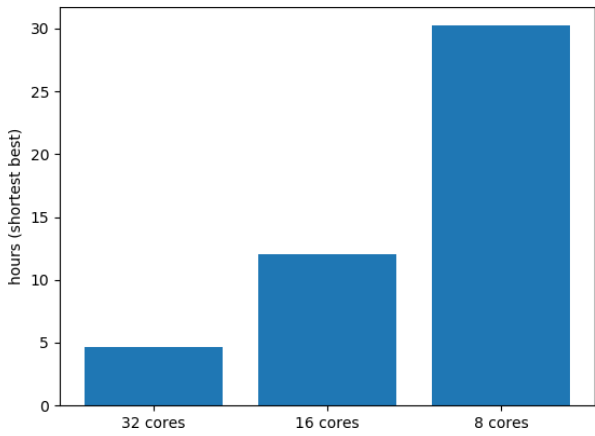
Figure 2. Processing time in hours to complete one year of simula- tion at 0.2 ◦ resolution in a “global” (65 ◦ S–65 ◦ N, 180 ◦ W–180 ◦ E) configuration spanning water depths of 10–100m. The high lati- tudes were removed because the model assumes constant salinity and the model does not include a representation of sea ice. Simula- tions were undertaken on an AMD 2990WX 32-core 3Ghz proces- sor with